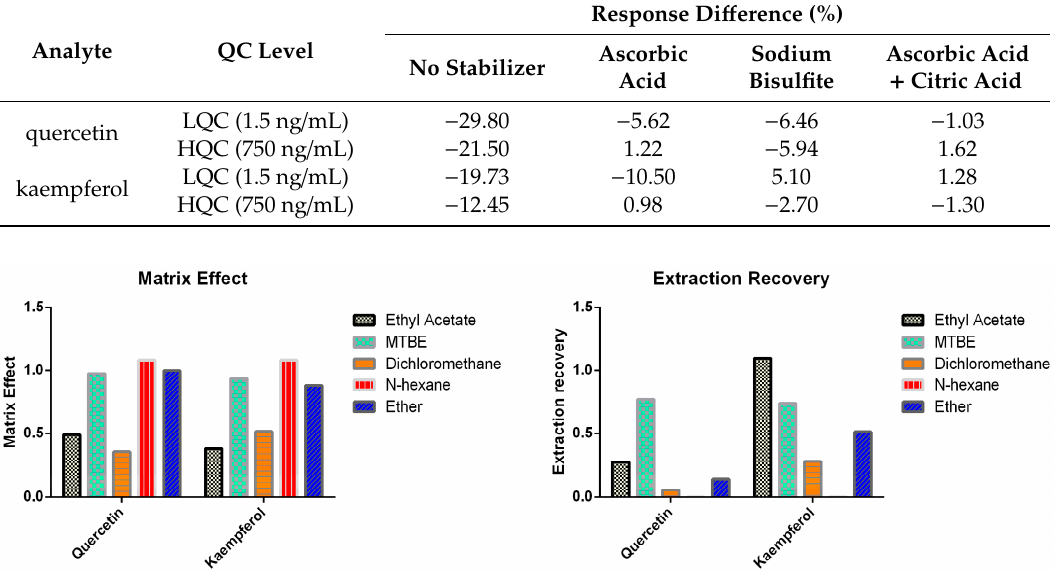
Table 1. Plasma stability at room temperature for 2 h of quercetin and kaempferol after using different stabilizers.